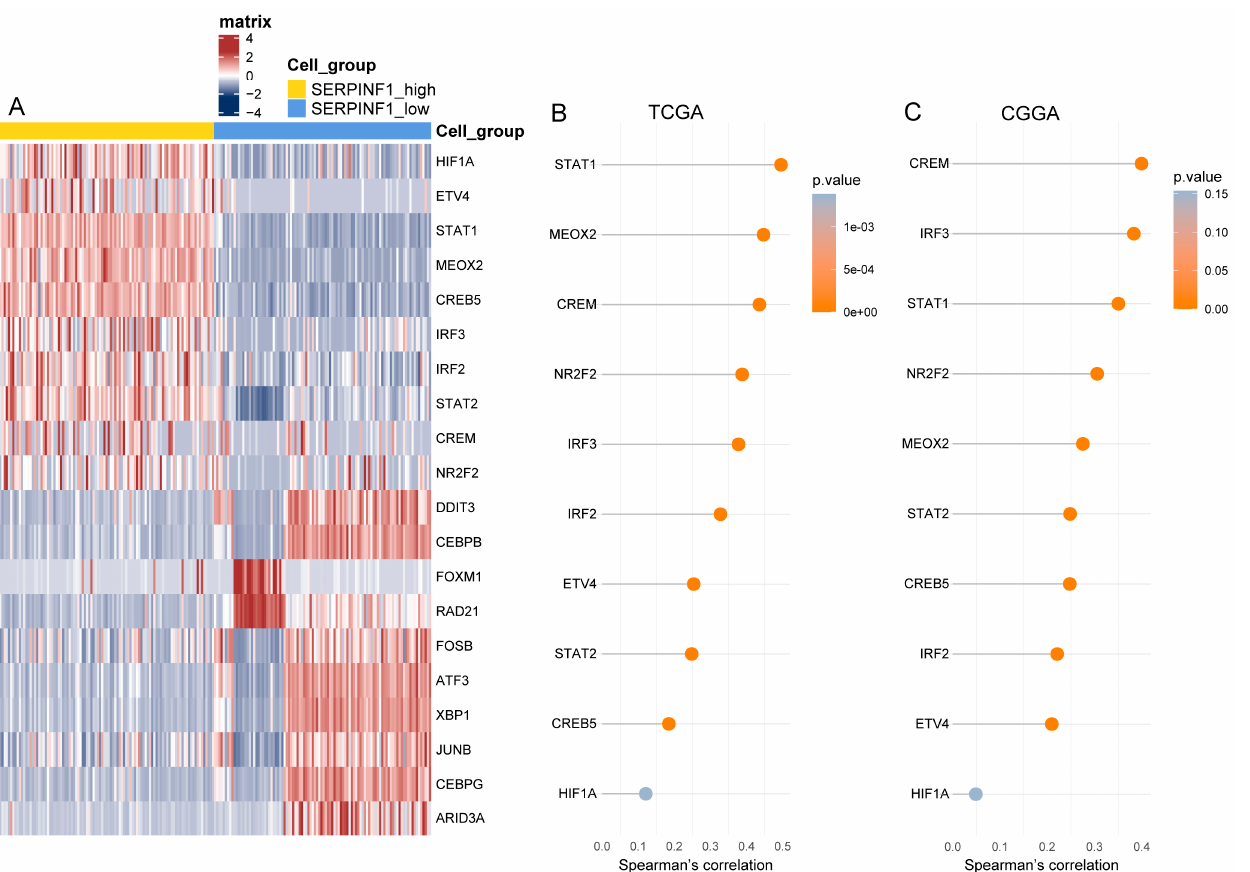
Figure 6. The signaling pathways associated with SERPINF1 expression at the single-cell level. ( A ) tSNE plot of the 2751 glioma cells with each cell color-coded based on the expression of SERPINF1. ( B ) SERPINF1 expression in nine subclusters of glioma cells visualized in a bubble plot. ( C ) Differ- ences in pathway activities scored per cell via GSVA between high- and low-SERPINF1 clusters. ( D ) Signaling pathways enriched in high-SERPINF1 cluster based on KEGG analysis at the single-cell level.